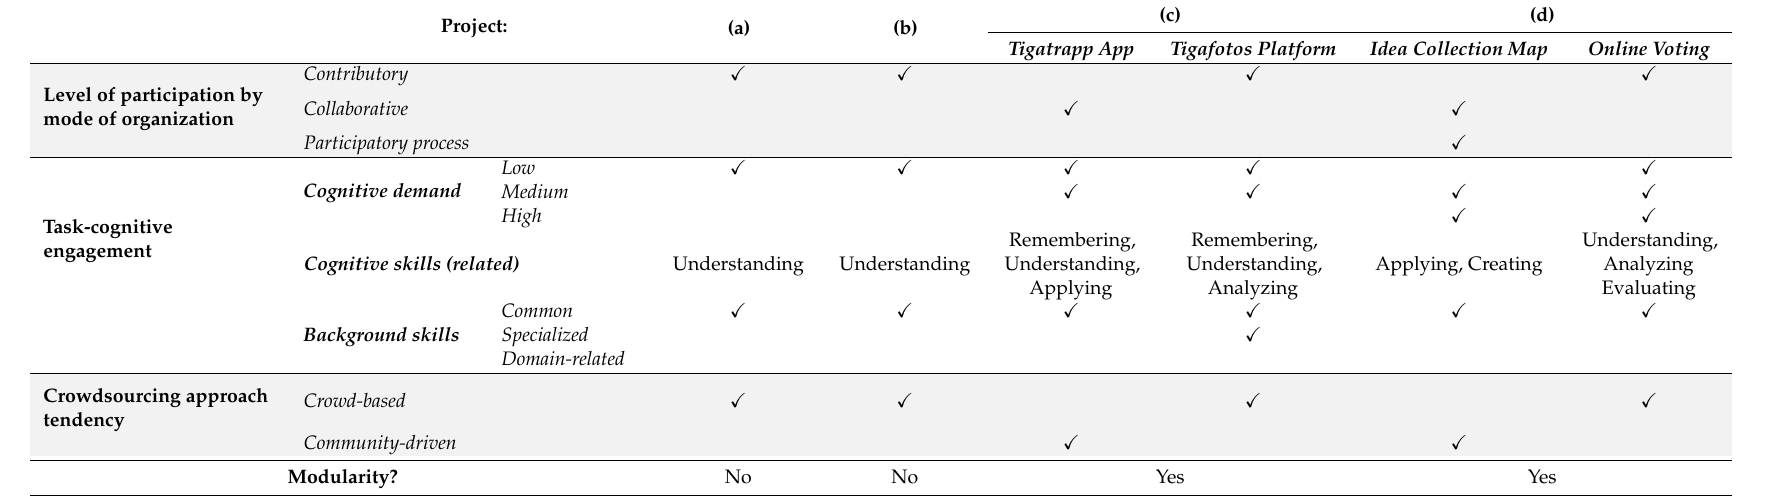
Table 6. VGI Project Design— Central Crowdsourced Processing Unit